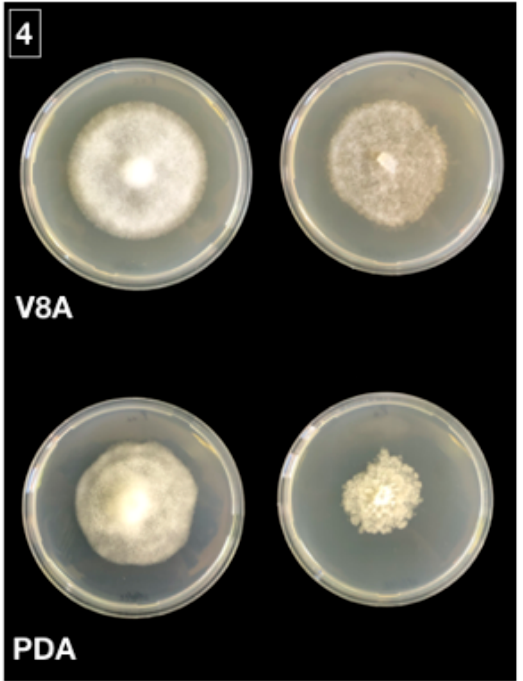
Figure 4. Colony morphologies of Phytophthora × cambivora (upper row and bottom row to the left; isolate MSK1A) and P. gonapodyides (upper row and bottom row to the right; isolate MSC1A) after 4 days growth at 20 °C in the dark on V8A and PDA.